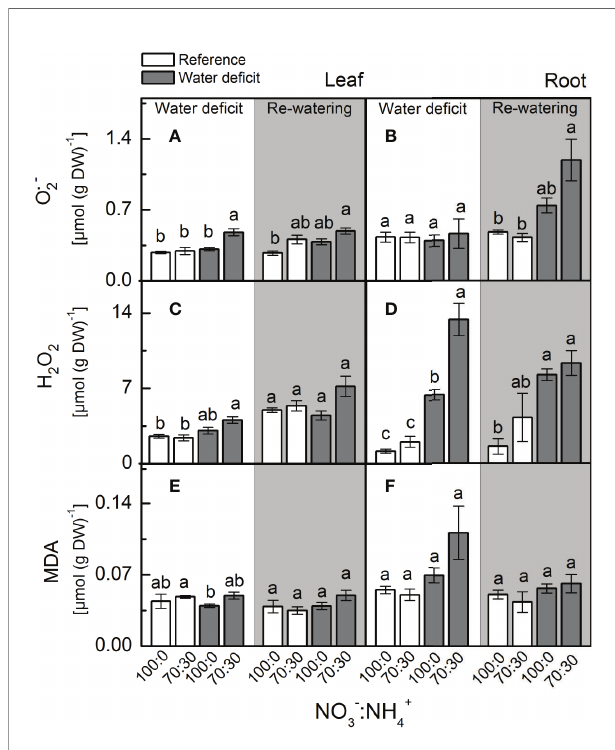
FIGURE 4 | Concentration of superoxide anion [O 2 (cid:129) − , in (A, B) ], hydrogen peroxide (H 2 O 2 , in (C, D) ] and malondialdehyde [MDA, in (E, F) ] in leaves (A , C , E) and roots (B , D , F) of sugarcane plants maintained well-hydrated (reference, white bars) or subjected to water de fi cit (gray bars) and supplied with varying NO 3 − :NH 4+ ratios: 100:0 and 70:30. The white area indicates the period of water de fi cit and the shaded area indicates the period of re-water. Bars represent the mean value of four biological replicates ± se. Different letters indicate statistical difference (BF 10 > 3) among treatments in a given